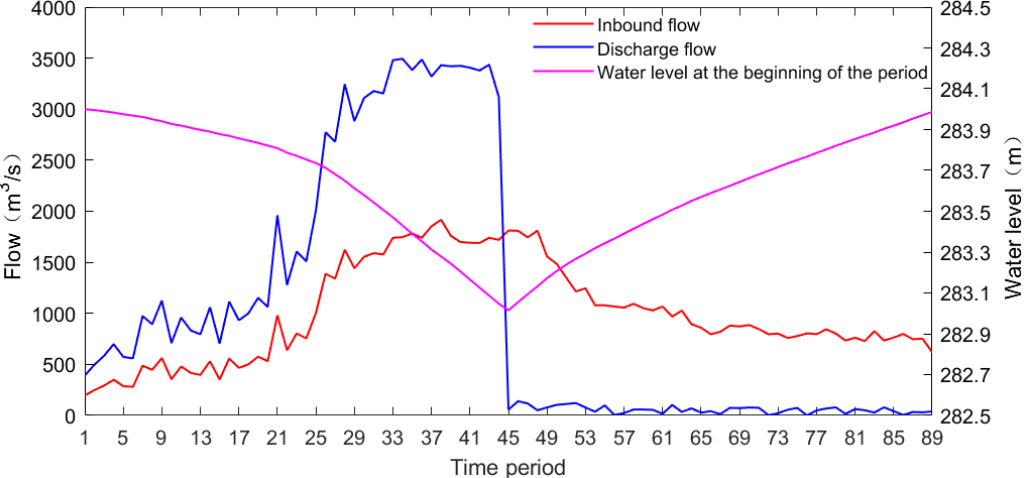
Figure 14. Optimal scheduling results of the second flood with the maximum flood control safety guarantee criterion.